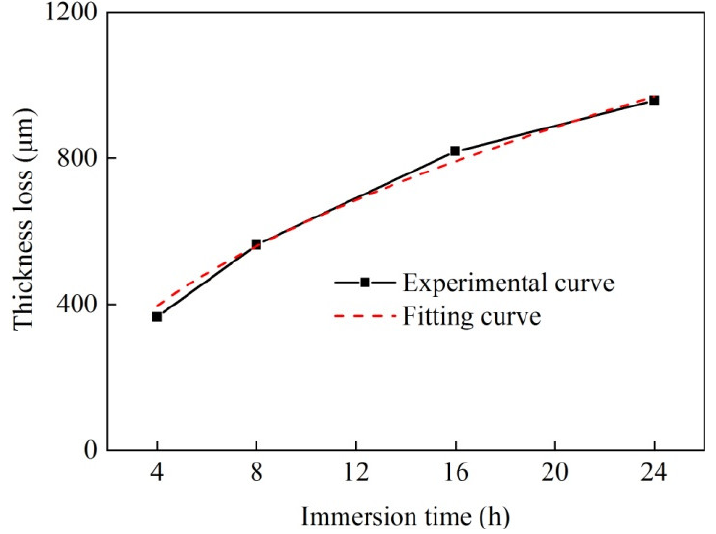
Figure 8. The loss of thickness of the intermetallic compounds with immersion time.